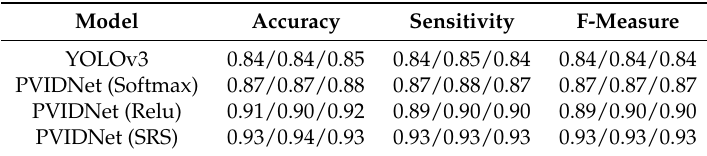
Table 13. Results of the DL algorithms to classify the images of ambulances (right/left/front) in the testing phase.